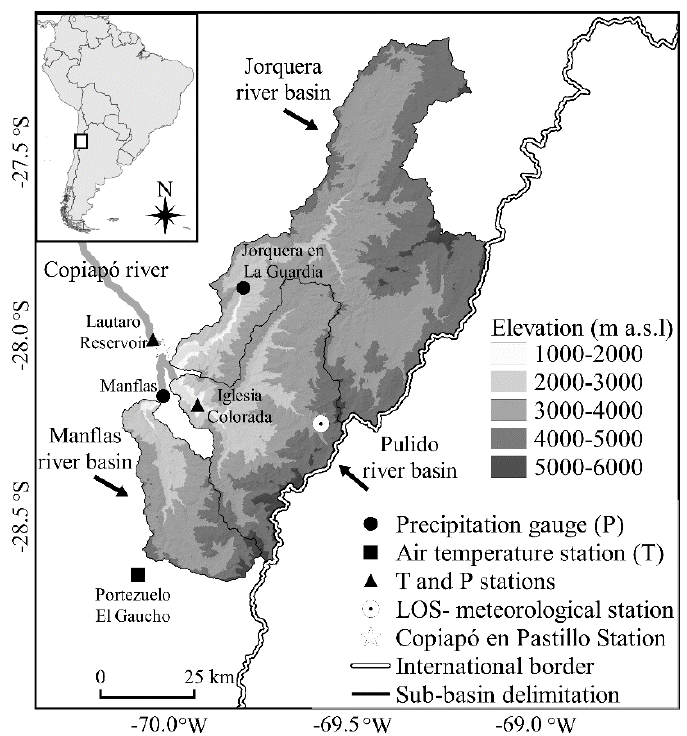
Figure 1. Location of the Upper Copiap ó river basin and its three tributaries; from north to south, Jorquera river basin, Pulido river basin and Manflas river